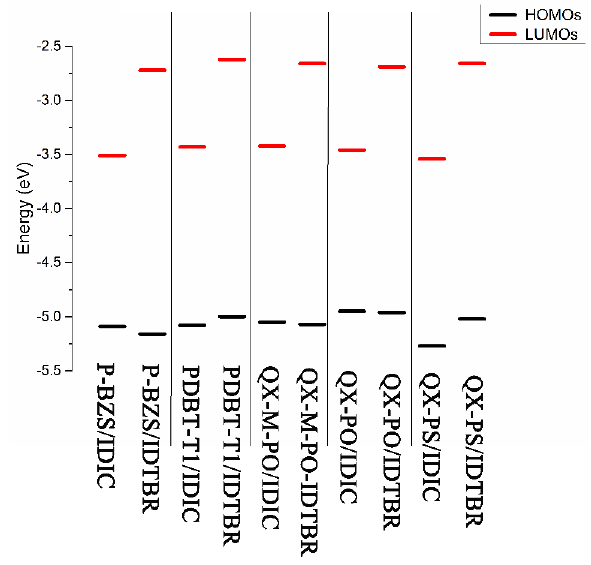
Figure 8. The FMOs energy levels of the five polymer/IDIC interfaces and the five polymer/IDTBR interfaces, where black line represents HOMO level and red line represents LUMO level.